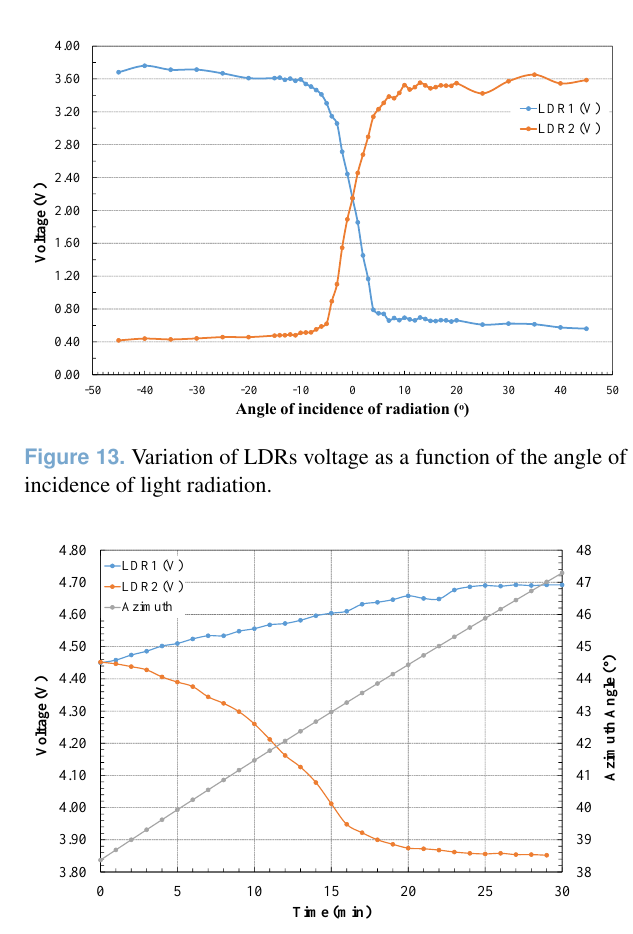
Figure 14. Variation of LDRs voltage as a function of the azimuth angle.